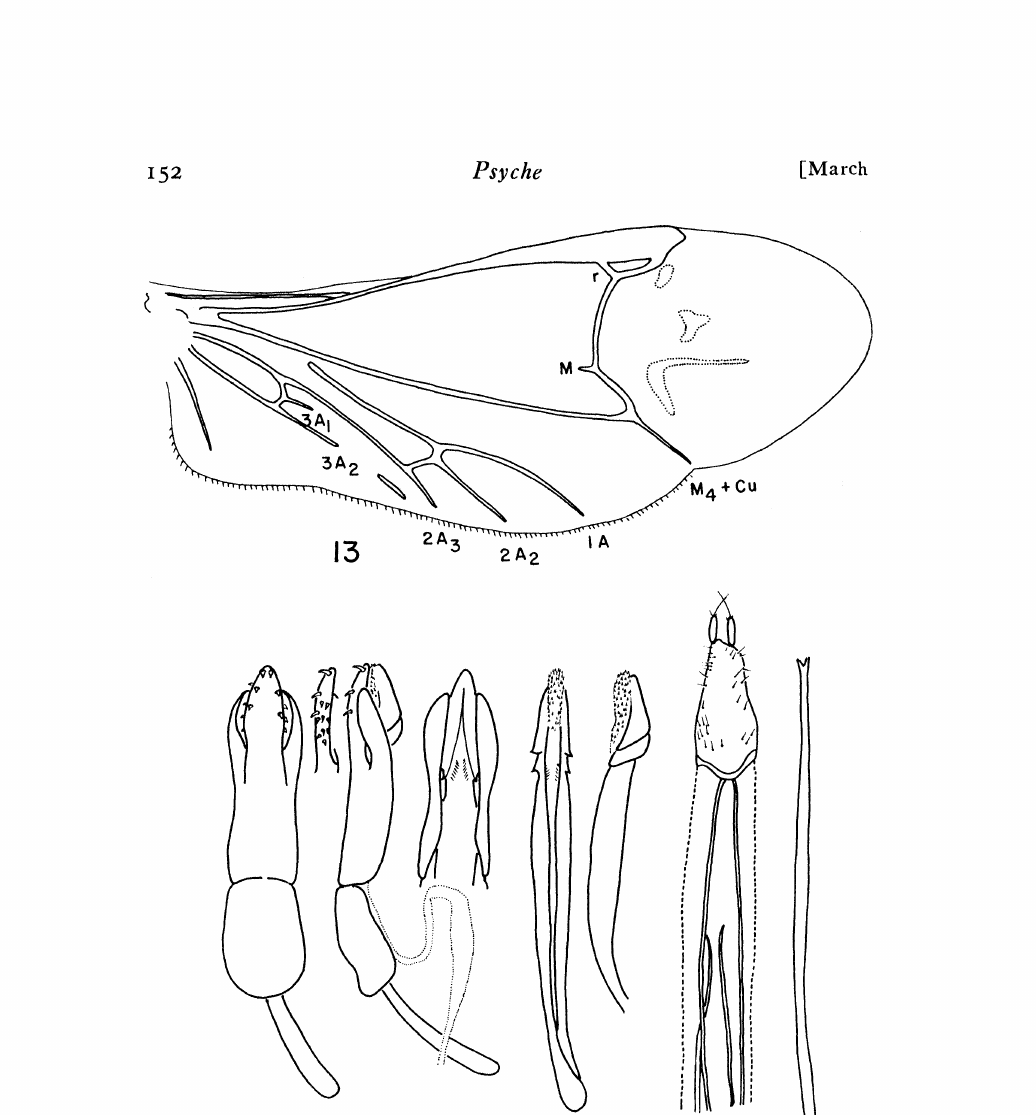
Figs. 13-17. Thambospasta hodeni. 13, hind wings of paratype male; 14, genitalia of paratype male in dorsal, lateral, and ventral views, with inset of details of median process; 15, aedeagus of same in dorsal and left lateral views; 16, ovipositor of allotype female; 17, anterior apodeme of abdominal sternum VIII of same; Figs. 14-17 at 60X